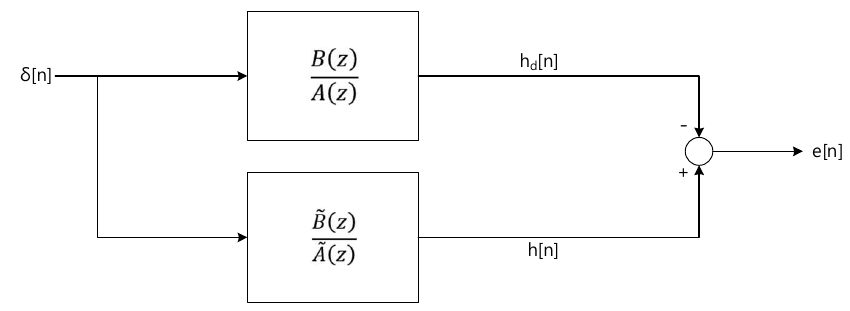
Figure 4. System model for Stiglitz-McBride algorithm.